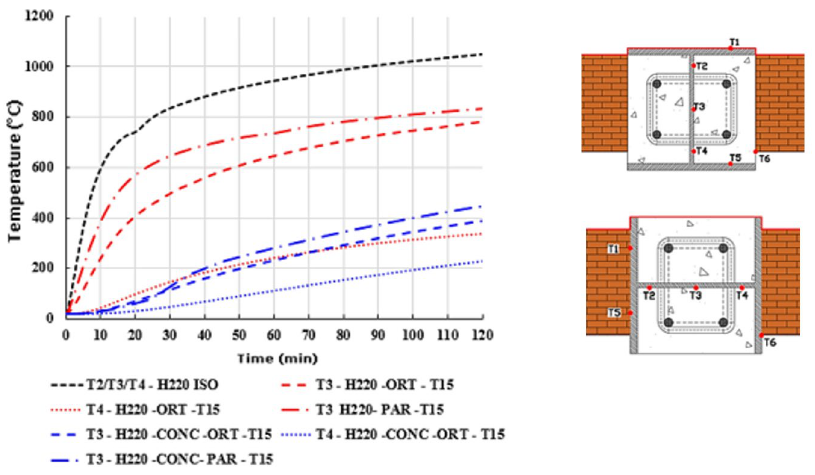
Figure 11. Curve for temperature versus time for columns (WEB).